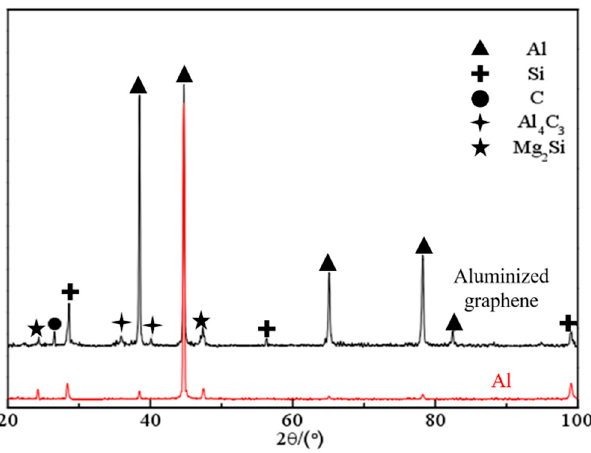
Figure 1. XRD patterns of SLM-formed AlSi10Mg and Gr/AlSi10Mg Composites